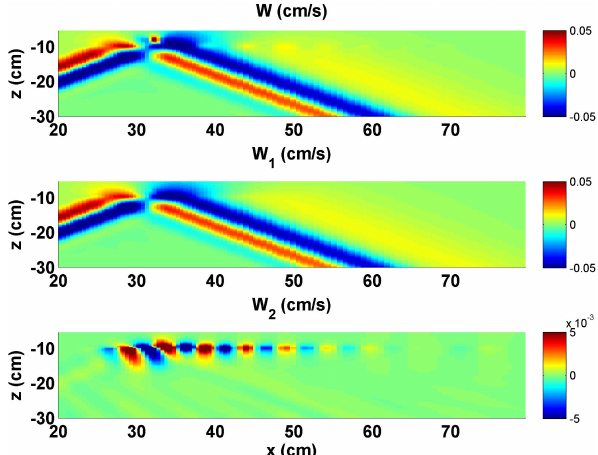
Figure 6. Snapshot of the vertical velocity field (top) for the simula- tion with θ = 25 degrees and r = 5. Time-filtered velocity fields for the ω f (middle) and 2 ω f (bottom) bands show the radiated harmonic wave beam.